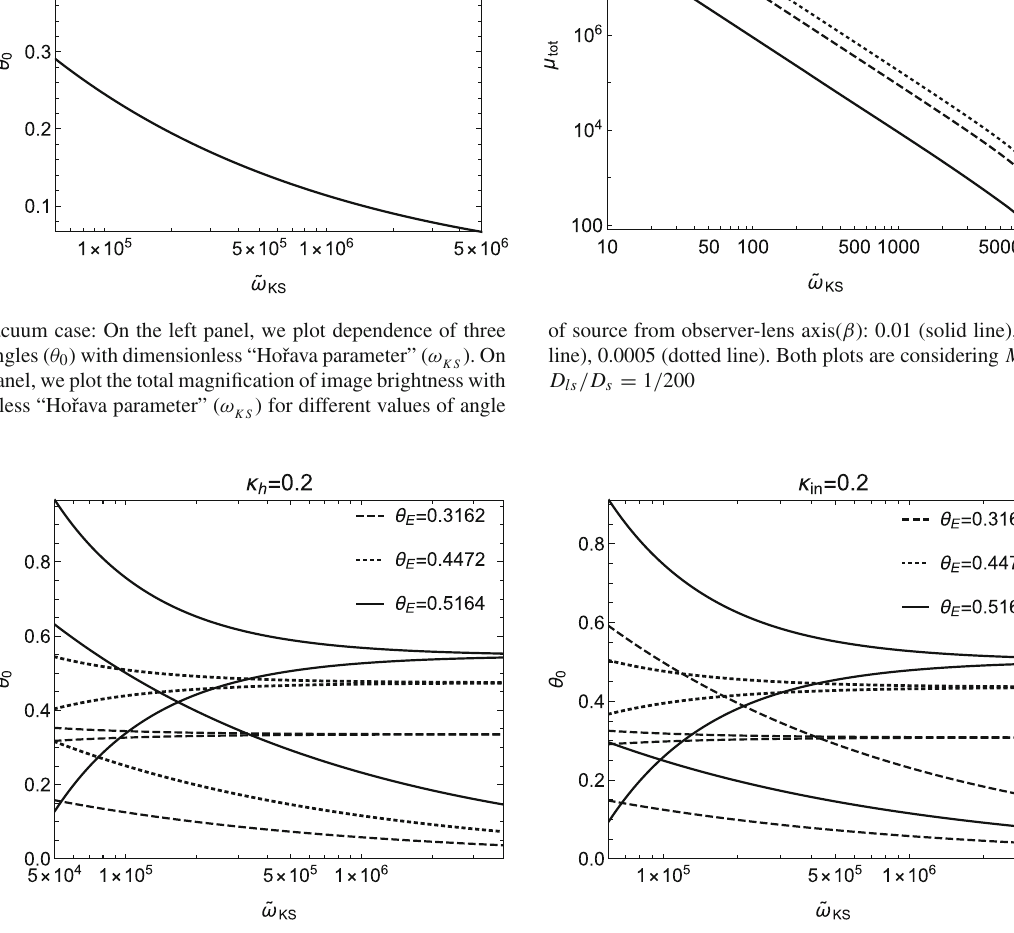
) for different KS